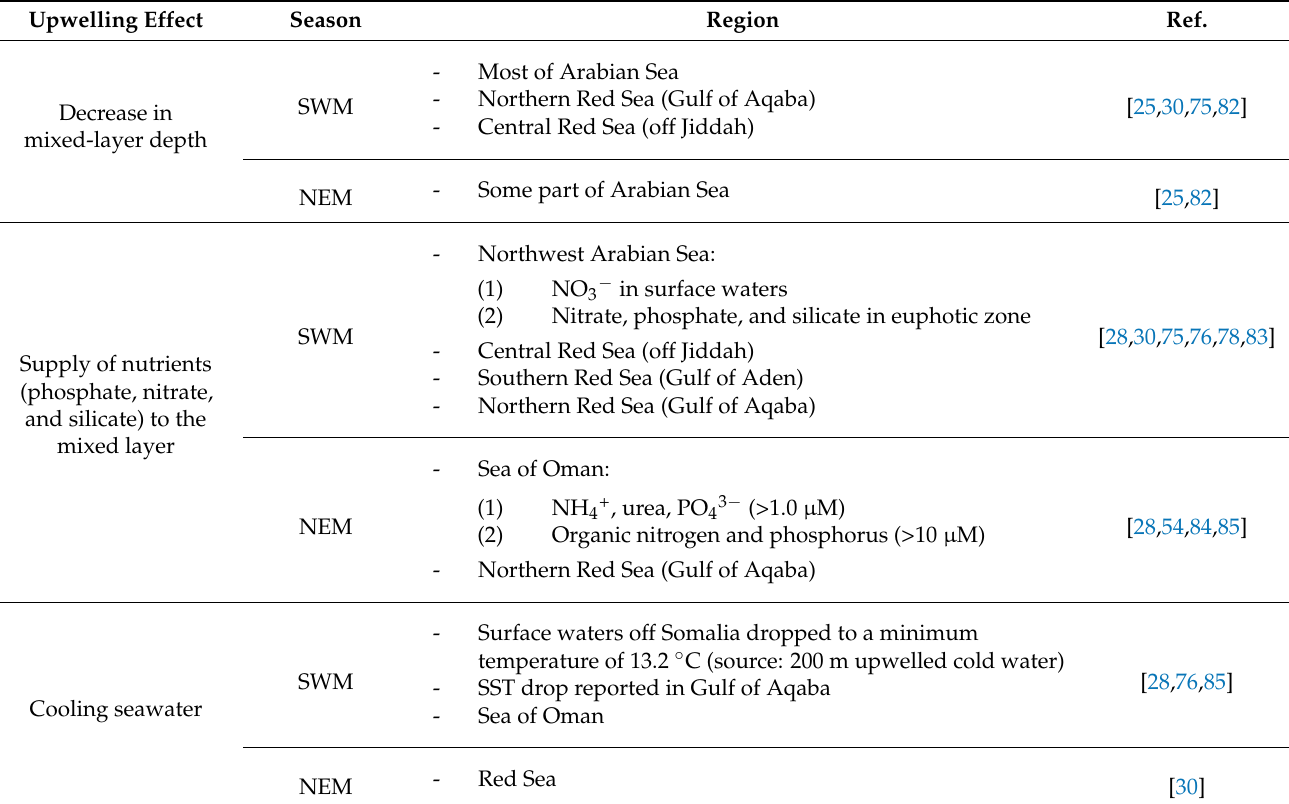
Table 4. Upwelling effects on NIO